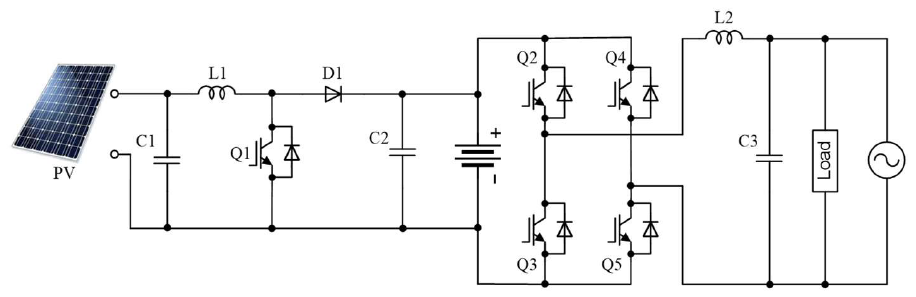
Figure 6. Battery link MPC with PV boost converter [48].